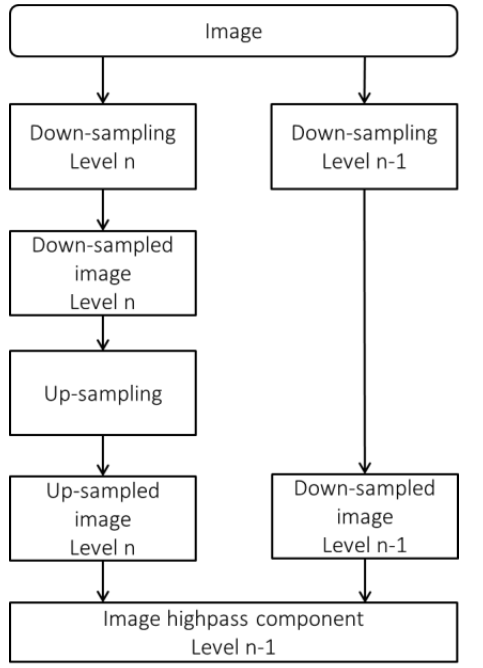
Figure 2. Workflow for computing the highpass component between two resampling levels